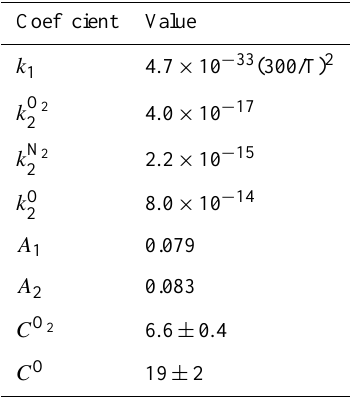
Table 2. Adopted rate coefficients and excitation parameters used in Eq. (6) for the retrieval of O from the measured O 2 A-band night- glow emission. C O and C O 2 are the excitation parameters derived empirically from the ETON data and describe the quenching of the precursor state by O and O 2 , respectively. All coefficients are in the usual units in terms of molecules, cm 3 , and